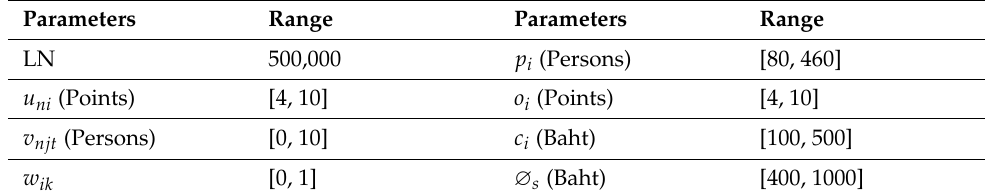
Table 6. The parameter range of the case study used to generate the data sets. Parameters Range Parameters